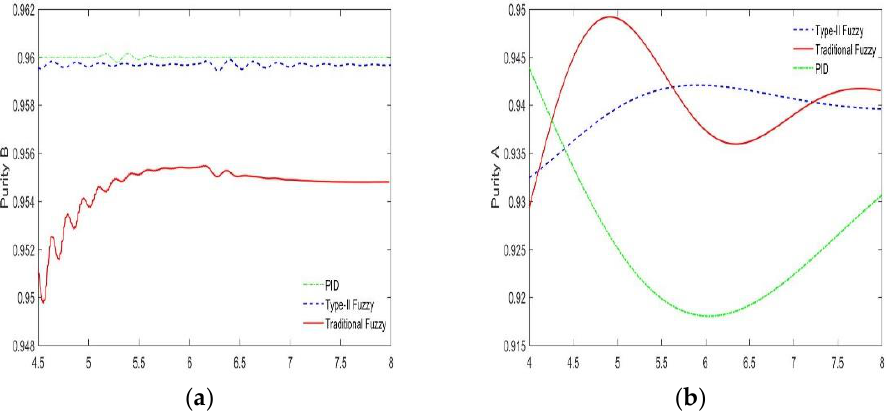
Figure 12. The control results of the three controllers (switch time = 180 s; desired A = 96%, desired B = 94%). ( a ) Extraction outlet (material B); ( b ) raffinate outlet (material A) .